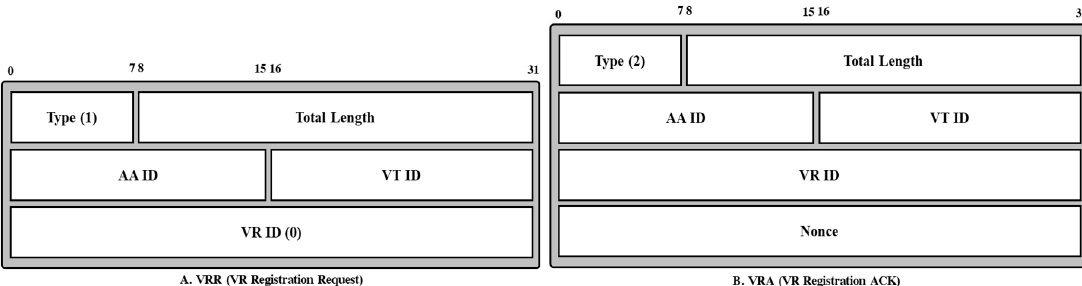
Figure 8. VR Registration Request (VRR) and VR Registration ACK (VRA) messages.